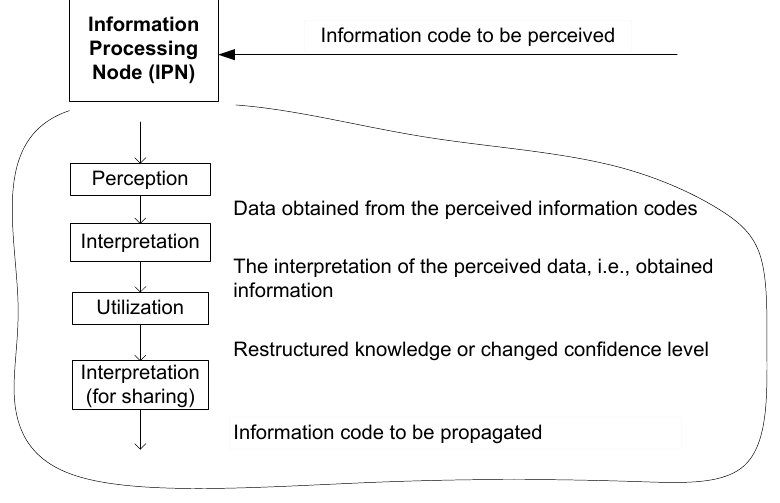
Figure 4. Inside the information processing